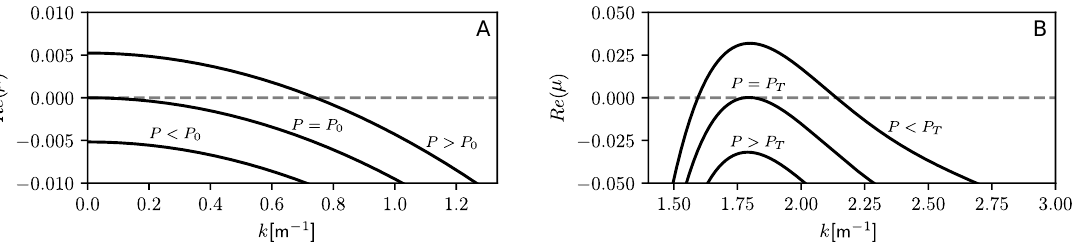
Figure A1. Dispersion relations for stable, marginally stable and unstable steady states. ( A ) Instability of the bare soil state to the growth of a uniform mode at P 0 = 175.3 mm/y (or ( kg/m 2 ) y − 1 ). ( B ) Instability of the uniform vegetation state to the growth of a non-uniform mode (of finite wavenumber) at P T = 296.2 mm/y. Precipitation values: ( A ) P = 299 > P T , P = 293.4 < P T , ( B ) P = 175.8 > P 0 , P = 174.2 < P 0 . Other parameters are fixed: E = 7 [ m 2 /kg ] , K = 0.4 [ kg/m 2 ] , M = 10.5 [ 1/y ] , N = 15 [ 1/y ] , Λ = 0.9 [( m 2 /kg ) /y ] , Γ = 12 [( m 2 /kg ) /y ] , R = 0.7, D B = 0.1 [ m 2 /y ] , D W = 50 [ m 2 /y ] , S 0 = 0.15m, c 0 = 1, c 2 = 0.0125, c 4 = 5.06 × 10 − 4 , c 6 = − 5.70 × 10 − 6 , c 8 = 3.33 × 10 − 7